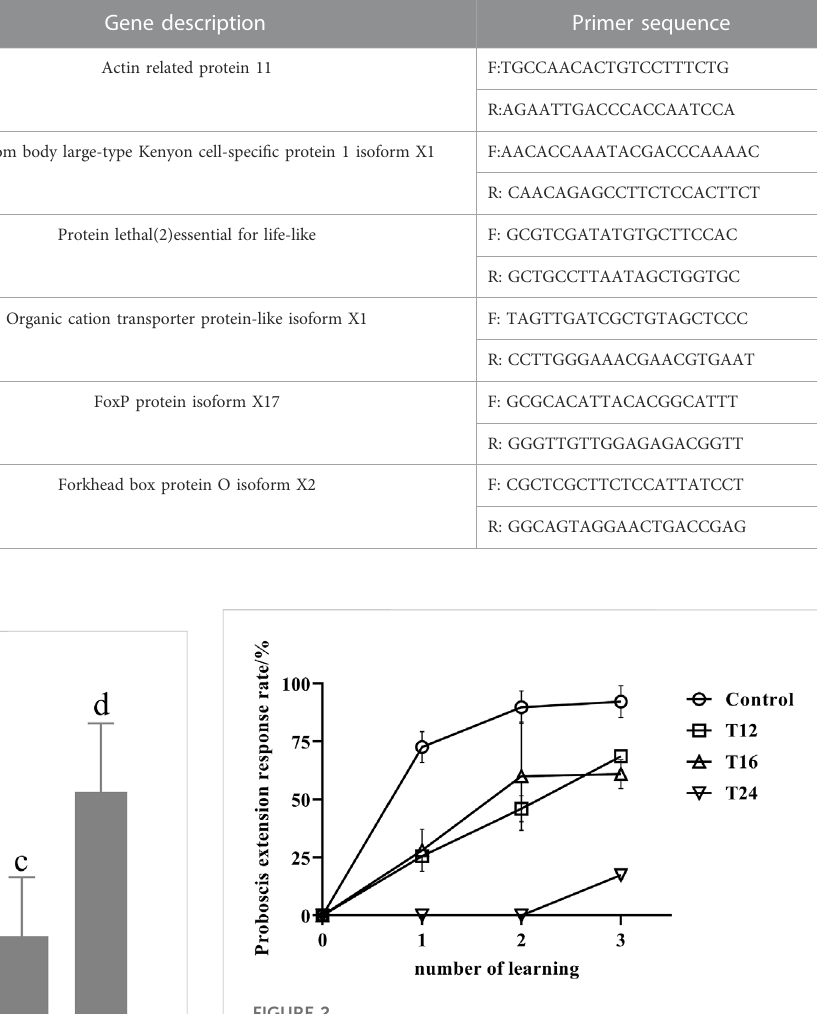
FIGURE 2 The association learning success rate (mean value ± standard deviation, ‾ X ± SD) of adult honeybee PER after low-temperature treatment. Note: The sample size of control group, T12, T16,